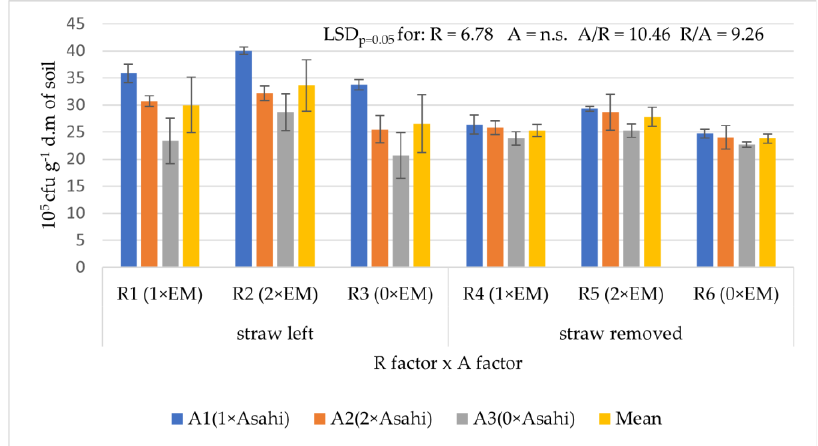
Figure 2. The number of actinobacteria in the soil, depending on the management of plant residues with the addition of the biopreparation EM (R factor) and the application of the biostimulant Asahi (A factor) in spring barley cultivation. Error bars represent standard deviation (abbreviations: see Table 1).